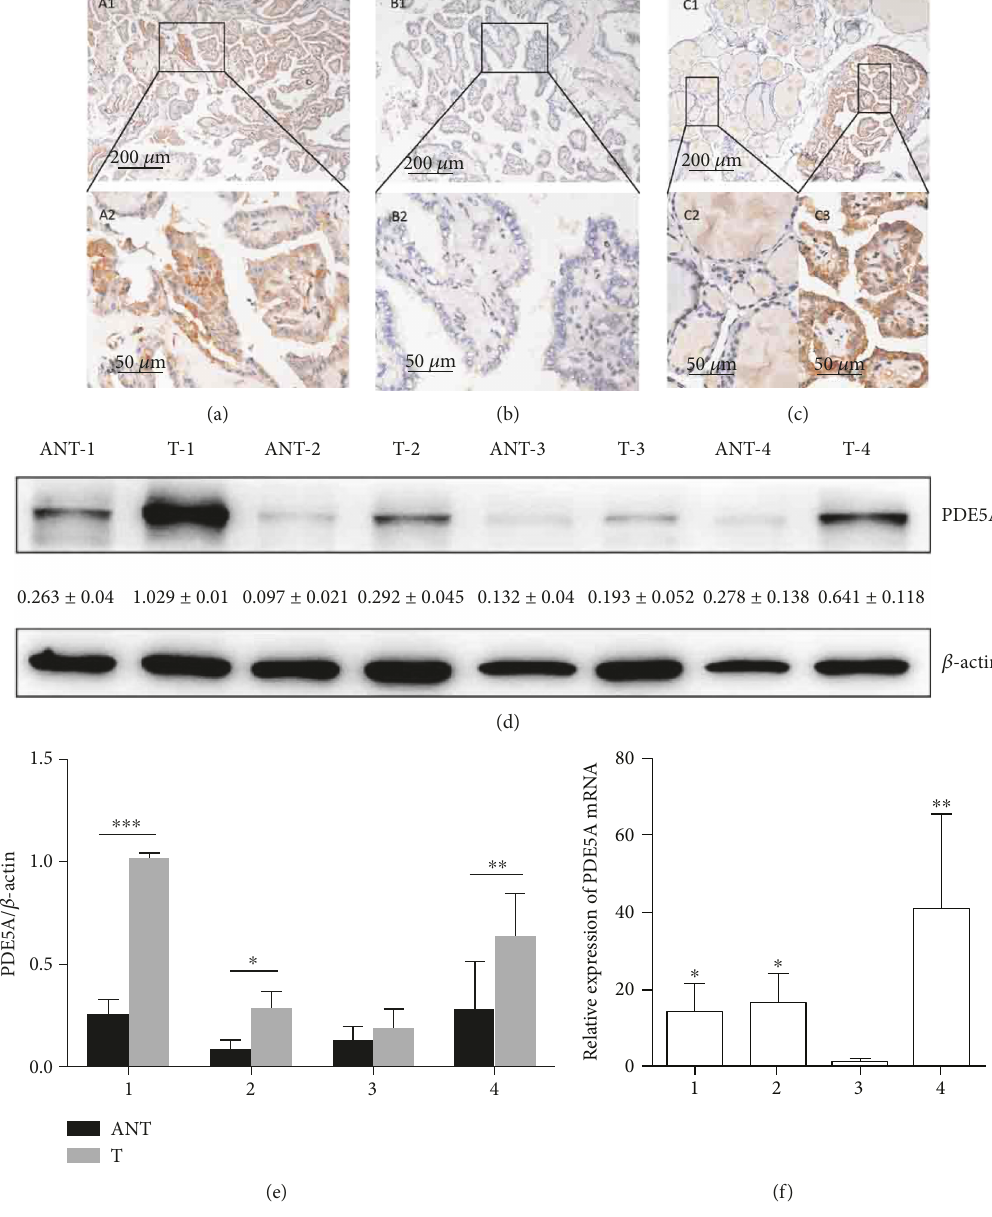
Figure 1: Upregulation of PDE5 expression in well-di ff erentiated thyroid carcinoma (WDTC). (a, b, c) Expression of PDE5 in WDTCs as determined by immunohistochemistry. Strong staining (A1, × 10; A2, × 40) and negative staining (B1, × 10; B2, × 40) can be observed. A WDTC sample (C1, × 10) with strong PDE5 staining in the carcinoma tissues (C2, × 40) and normal thyroid follicular epithelial cells with weak staining (C3, × 40). (d and e) Western blots show the expression levels of the PDE5 protein in four WDTC tumor tissues (T) and their paired adjacent noncancerous tissues (ANT); β -Actin was used as the loading control. (f) Real-time qPCR analysis results show the expression levels of PDE5 mRNA in WDTC tumor tissues relative to their paired adjacent noncancerous tissues (T/ANT). Values are given as the ratio of PDE5 expression to GAPDH expression ( ∗ P < 0 05 , ∗∗ P < 0 01 , and ∗∗∗ P < 0 001